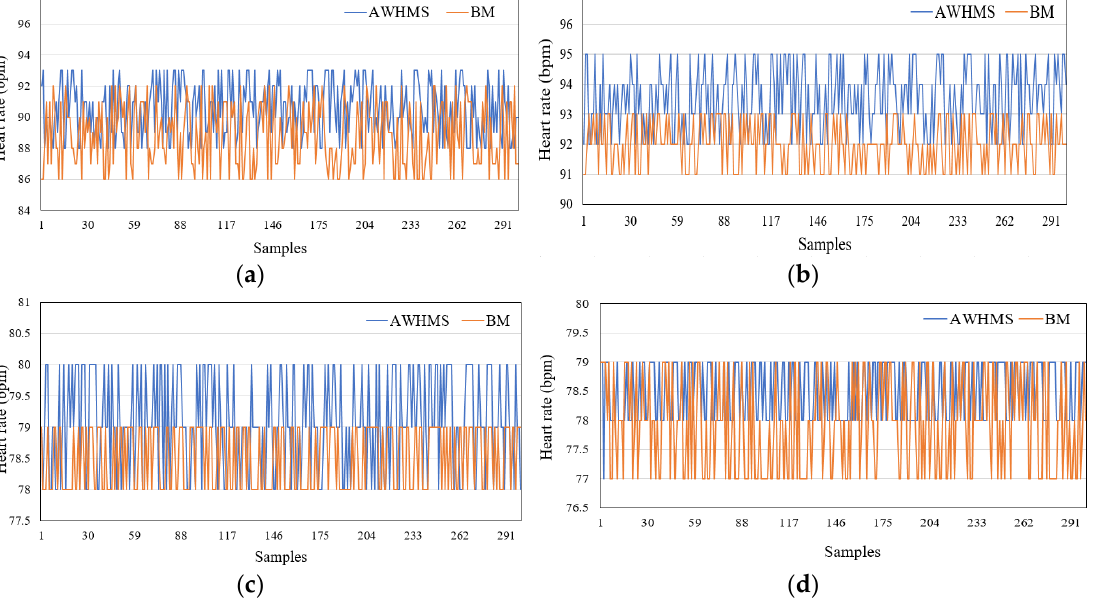
Figure 9. Plot of the data collected from the AWHMS and BM devices for volunteers ( a ) aged 23 to 25, ( b ) aged 26 to 29, ( c ) aged 61 to 63, and ( d ) aged 64 to 66 years.